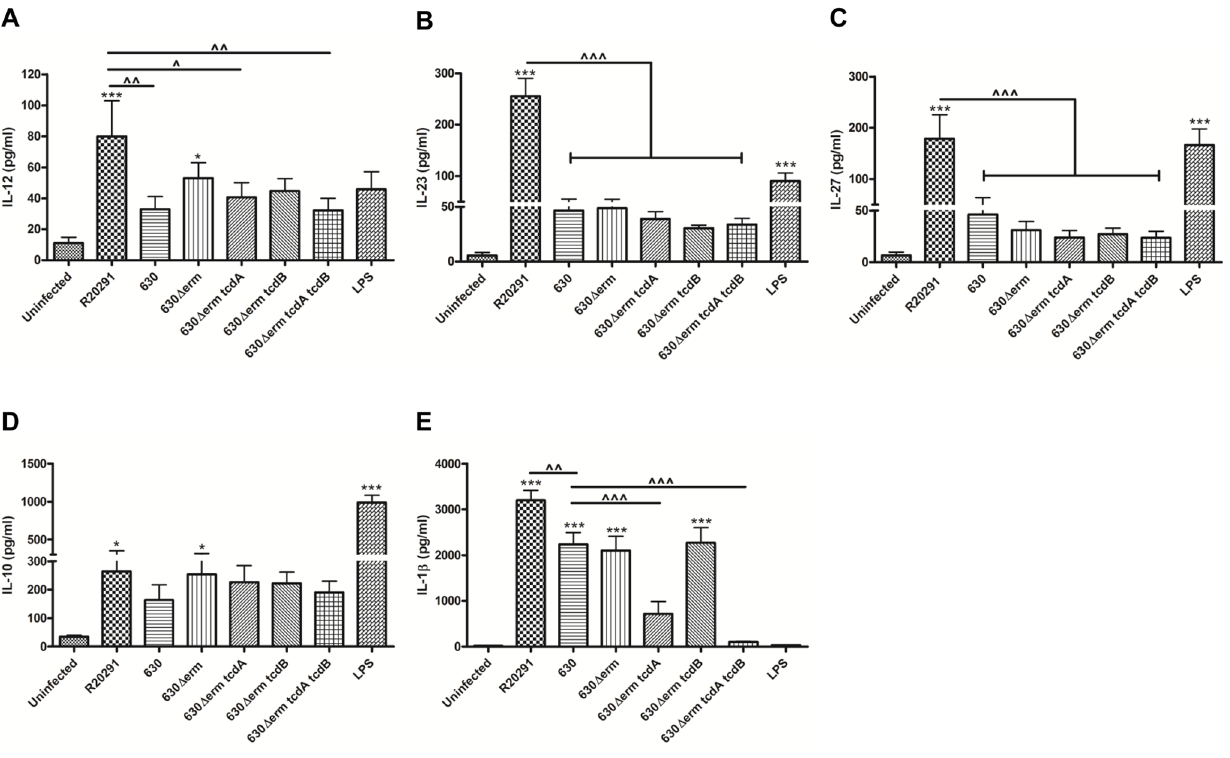
Figure 3. C.difficile -mediated effects on BMDC cytokine production. BMDCs were infected with C. difficile cultures at an MOI of 10 and IL-12 (A), IL-23 (B) IL-27 (C), IL-10 (D) and IL-1 b (E) was measured 8 h post-infection. 1 m g/ml LPS stimulation served as positive control. Data represent mean 6 SEM of duplicate samples and are representative of three individual experiments. */ ‘ p , 0.05, ‘‘ p , 0.01 and ***/ ‘‘‘ p , 0.001 represent significant difference from uninfected cells and significant inter-strain difference. P values were obtained using ANOVA with Bonferroni post-test analysis.